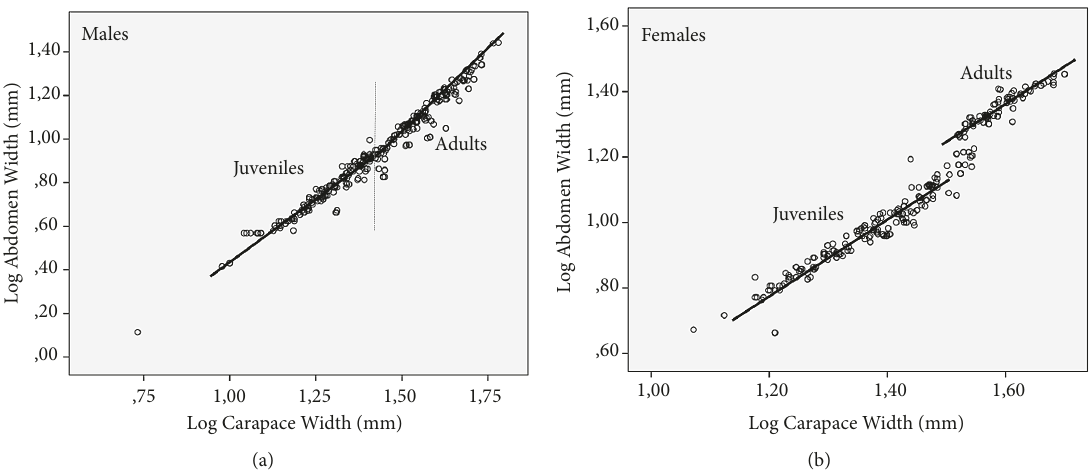
Figure 3: Dispersion points and adjusted curve of the relationships: (a) ChW vs. CW; (b) AW vs. CW for males and females of Potamon algeriense,